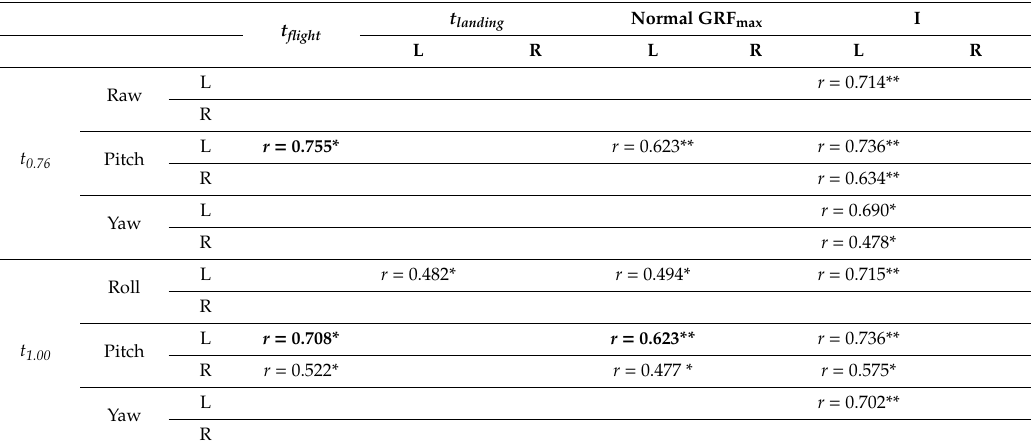
Table 3. Correlations between t flight, t landing , normal GRF max , and impulse I acting on the left (L) and right (R) foot, and the ski roll, pitch, and yaw ROM of the L and R side at t 0.36 , t 0.56 , t 0.76 , and t 1.00 of